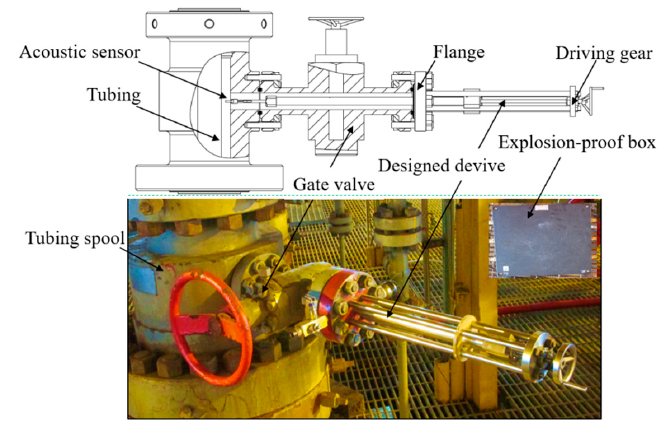
Figure 18. Picture of field testing.